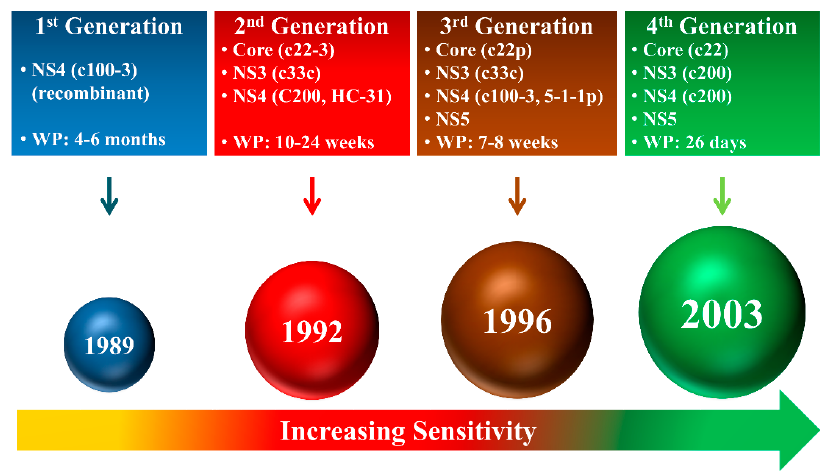
Figure 5. Generations of the protein-based HCV assays (WP, window period).